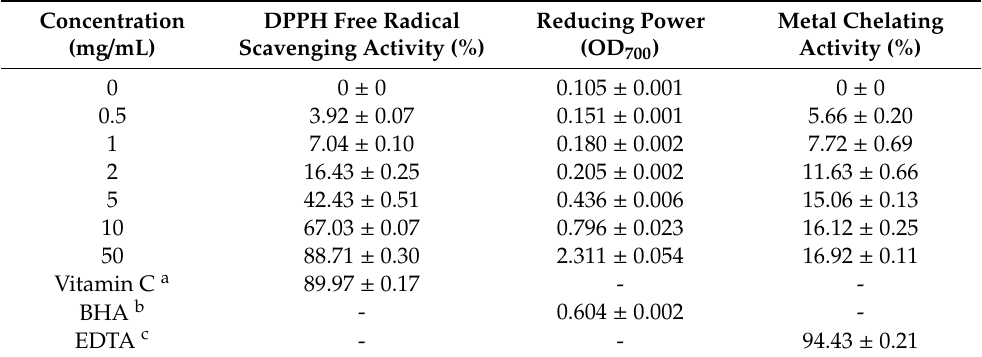
Table 2. The e ff ect of antioxidative activity assays on Phyllanthus emblica at di ff erent concentrations.